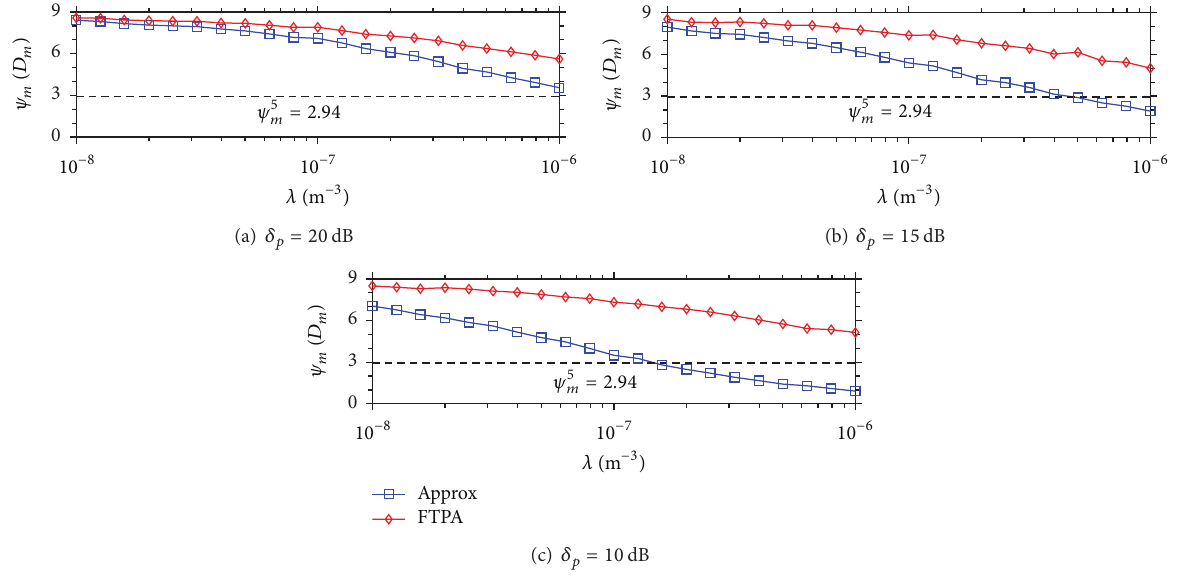
Figure 7: Mean SINR of each MU when the QoS type is data ( 𝜓 5 𝑚 = 2.94 dB).